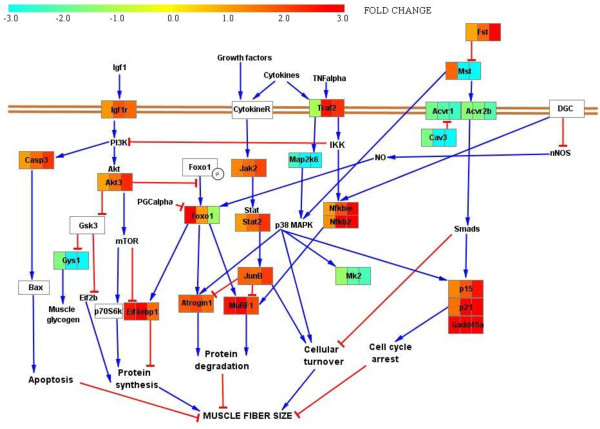
Schematic illustration of the major pathways that control adult skeletal muscle size. Significant differentially expressed genes playing important roles in these pathways were mapped according to their expression level at the three time point groups (0.25-4d, 5-8d and 9-14d); turquoise = down-regulated genes, red = up-regulated genes and yellow = unregulated genes. Red lines indicate inhibition and blue lines activation.